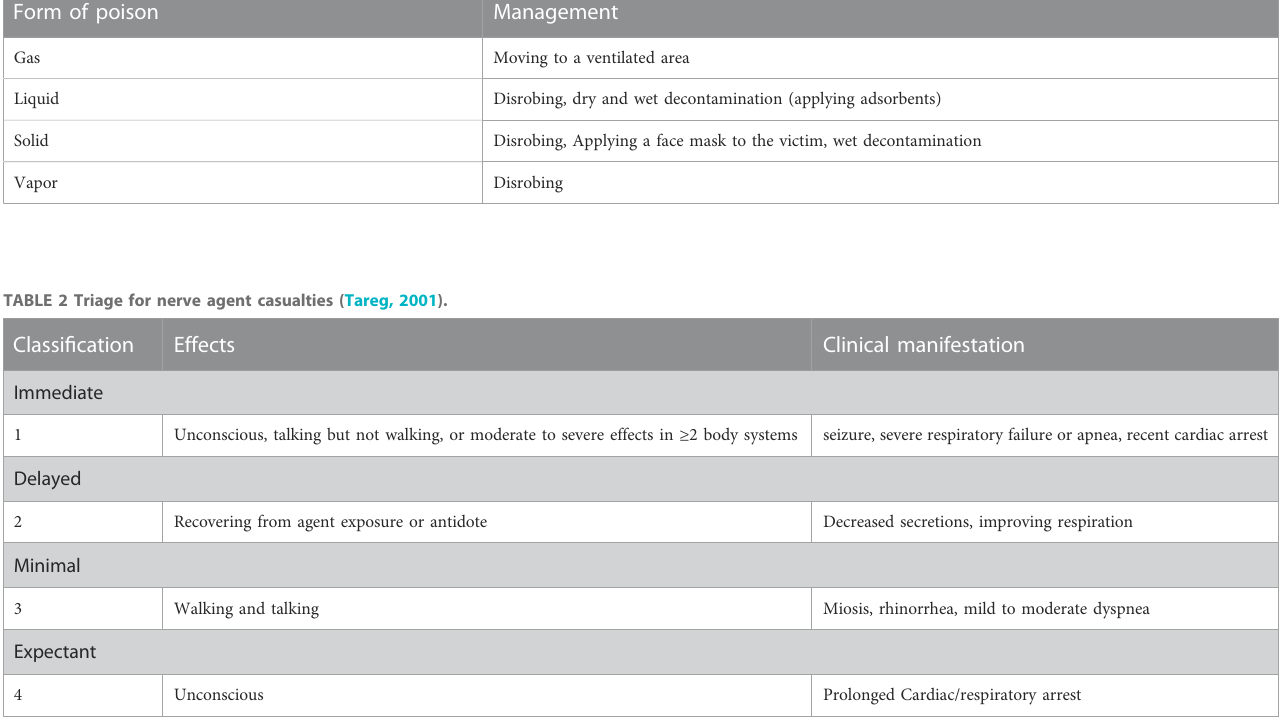
TABLE 1 Decontamination rules for different forms of nerve agents.